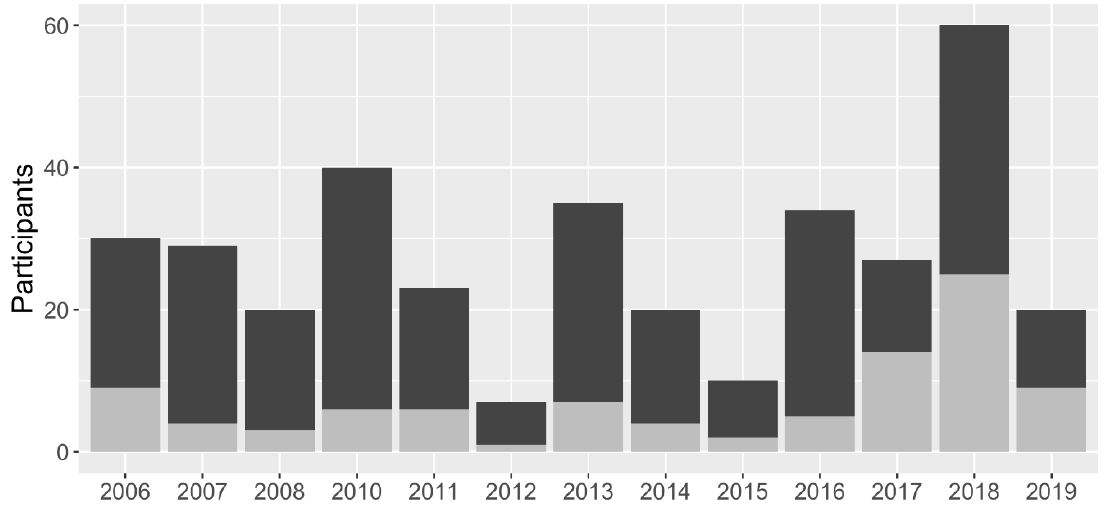
Figure 1. The number of participants in the NOAA satellite course since 2006 (black), and the number of survey responses received back from each year’s participants (gray).